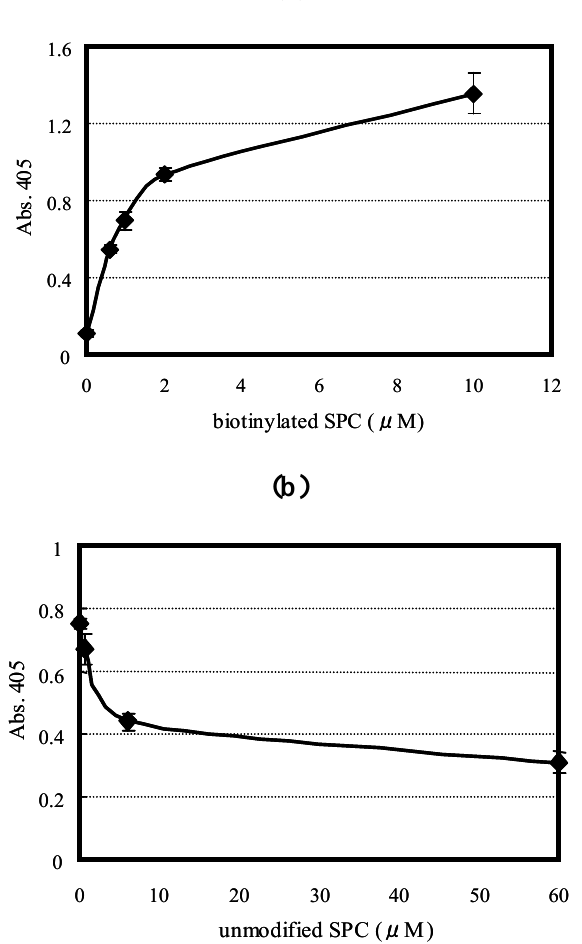
Figure 6. ELAA. (a) Sensitivity of the m012 aptamer for biotinylated SPC. The amount of biotinylated SPC captured by immobilized m012 was shown as the absorbance at 405 nm. The experiment was repeated three times with each data point measured in duplicates, and a representative result is shown. (b) Competitive ELAA using m012 and biotinylated and unmodified SPC. The biotinylated and serially diluted unmodified SPC were added to the m012-immobilized plate. The amount of biotinylated SPC captured by the immobilized m012 was shown as the absorbance at 405 nm. The experiment was repeated three times with each data point measured in duplicates, and a representative result is shown. (c) Specificity of the m012 aptamer for SPC and S1P. The amount of the biotinylated m012 reacted with the immobilized biotinylated SPC and S1P was shown as the absorbance at 405 nm. The experiment was repeated three times in triplicates, and a representative result is shown. Error bars show standard